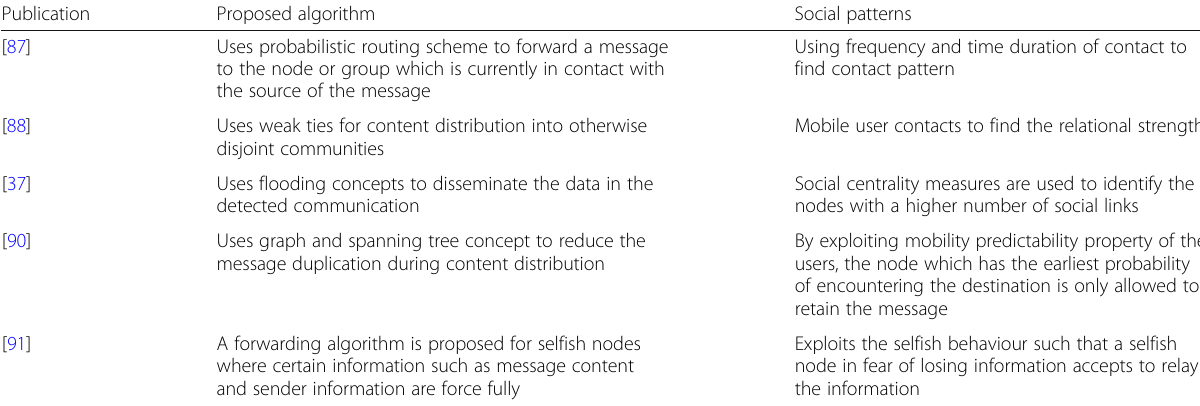
Table 8 Social pattern techniques Publication Proposed algorithm Social